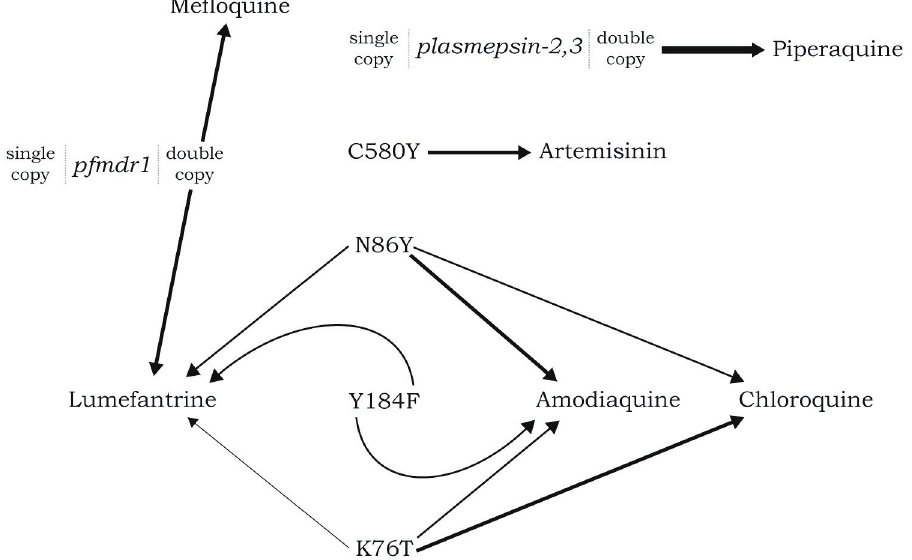
Fig 2. Diagram showing pleiotropy of loci affecting drug-resistance phenotypes. An arrow pulling on an allele or genotype indicates that that drug selects for that allele or copy-number variant. For example, amodiaquine selects for alleles 86Y and Y184 in the pfmdr1 gene and allele 76T in the pfcrt gene. Thicker arrows indicate stronger selective pressure according to the drug-by-genotype interactions developed by Nguyen et al.